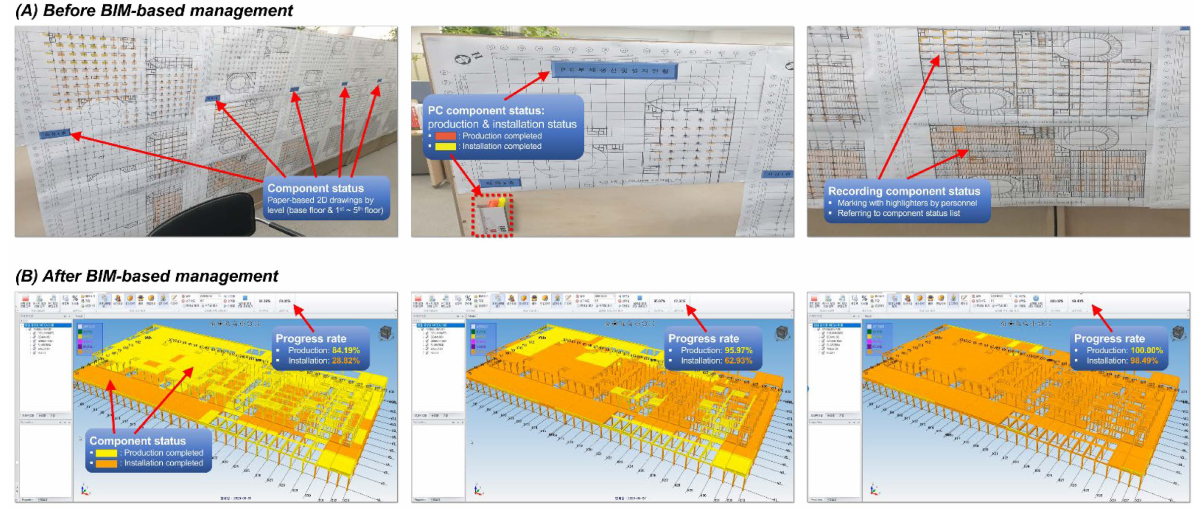
Figure 9. Real-time progress monitoring and